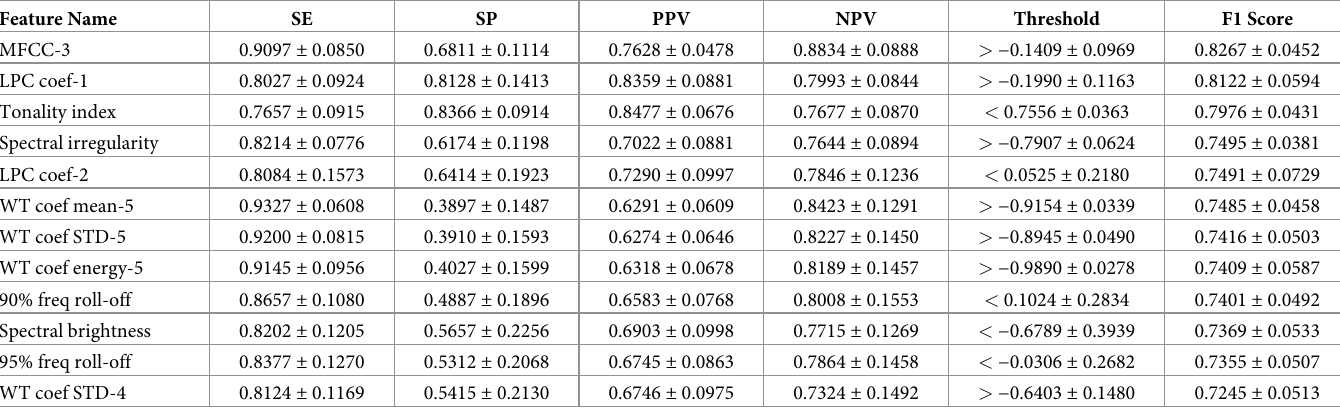
Table 4. Classification result using optimum F1 score threshold on the